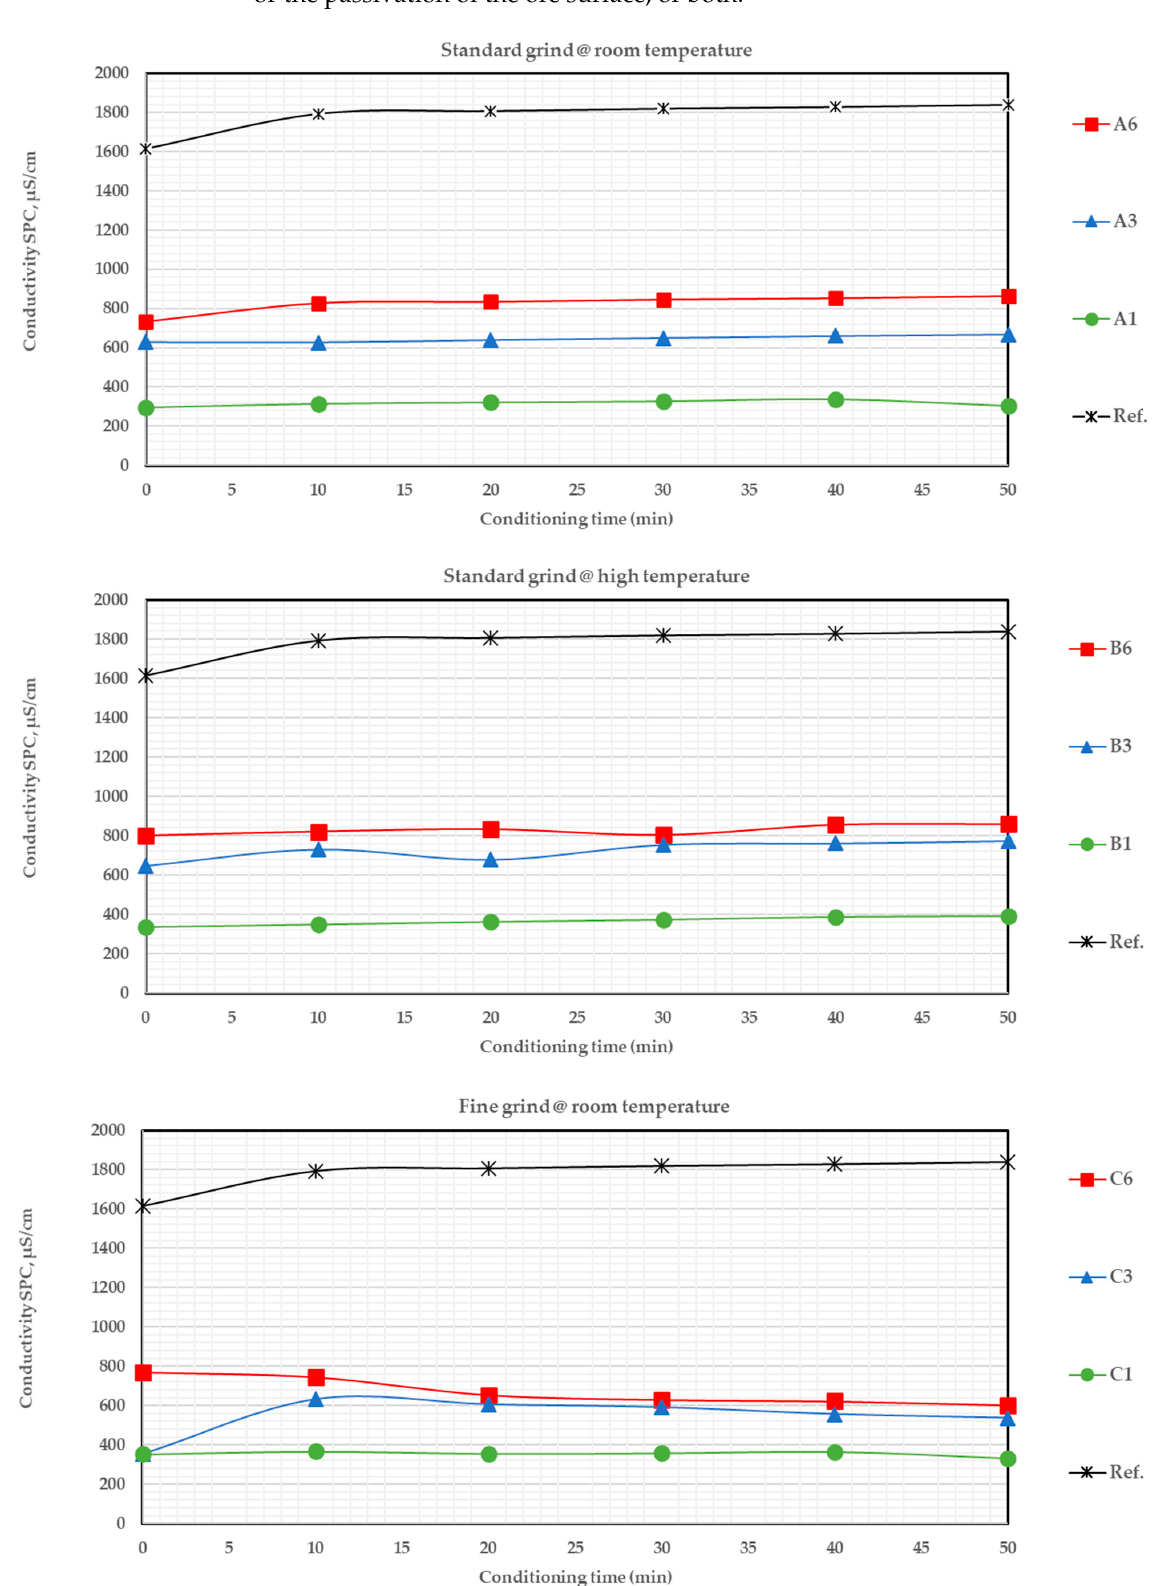
Figure 3. Effect of dissolution loop and dissolution time on SPC.